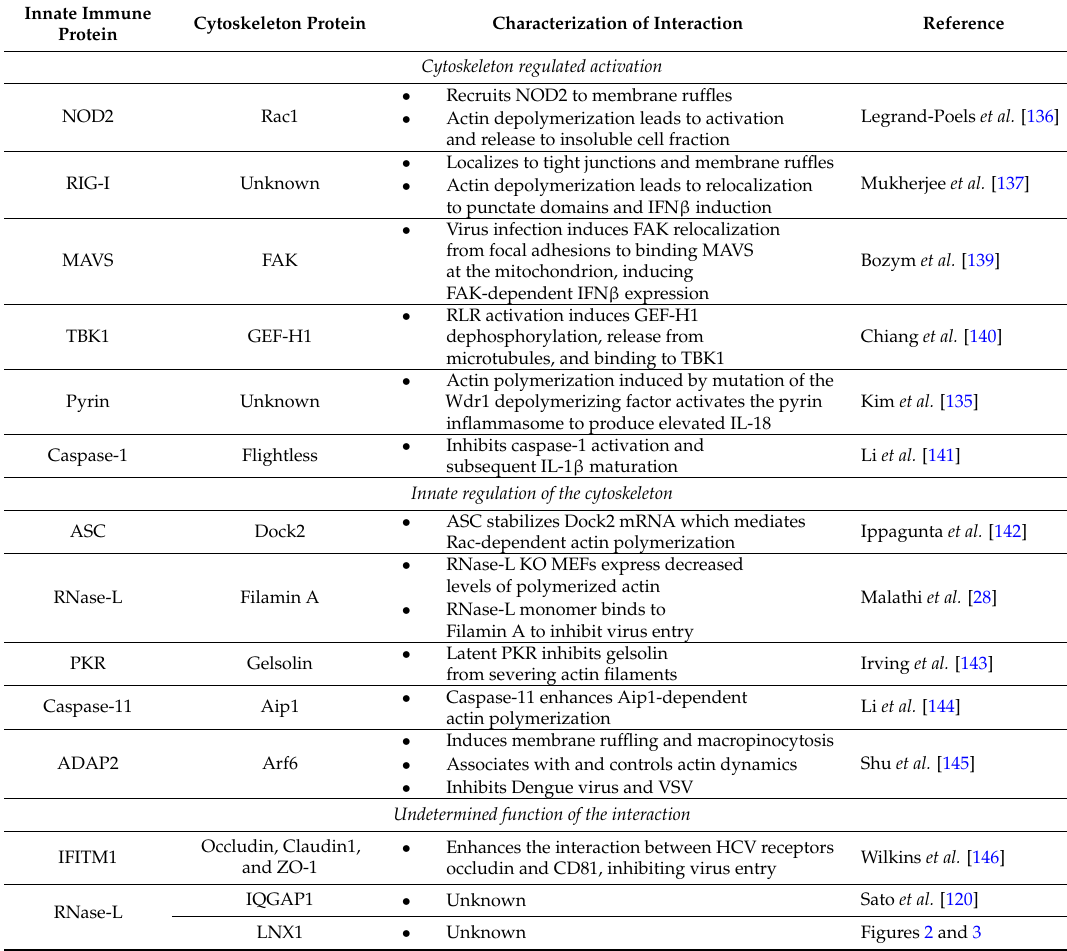
Table 1. Cytoskeletal interactions with members of the innate immune